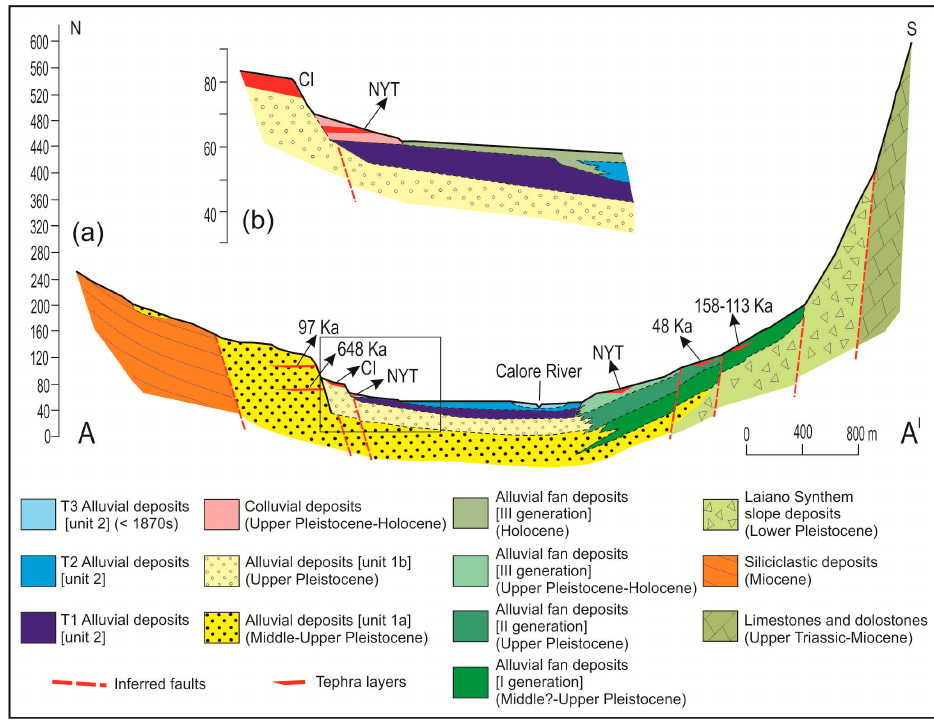
Figure 4. ( a ) Schematic geological cross section through the Calore River valley in sector A. See Figure 2 for location; ( b ) detail of the geological cross section showing the relationships between the colluvial deposits containing reworked Neapolitan Yellow Tuff (NYT) deposits, the T1 and T2 alluvial deposits and the deposits of the third generation of AF along the right valley side.